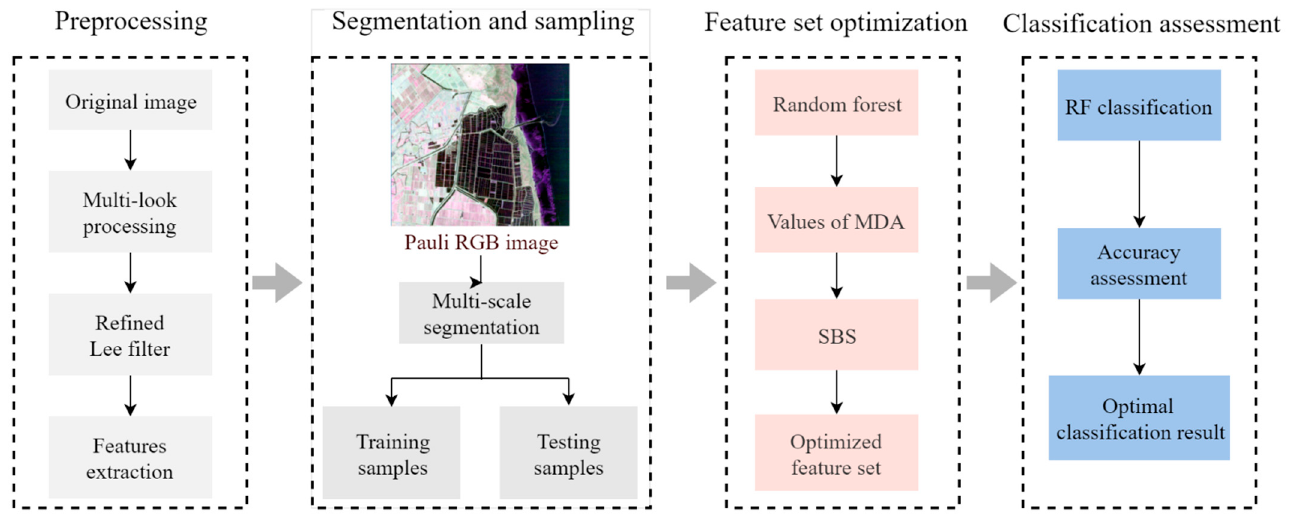
Figure 3. Workflow for coastal wetland classification using GF-3 data.